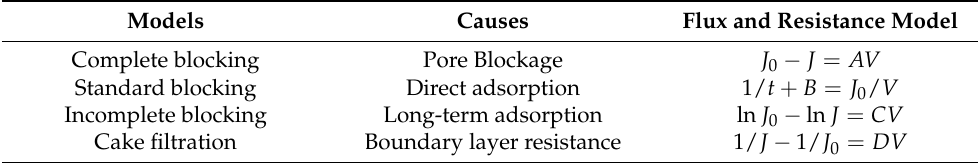
Table 1. Types and causes of membrane fouling models.